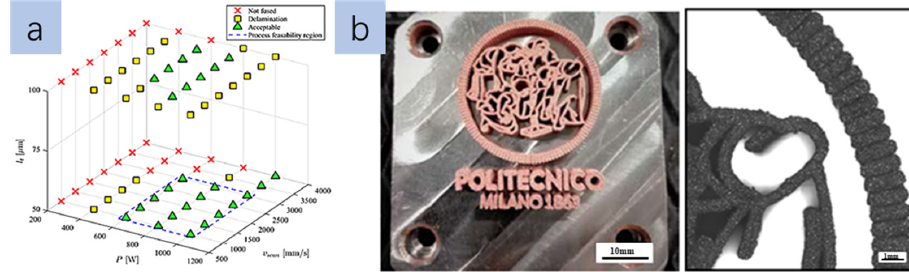
Figure 11. ( a ) Qualitative categorization of process outcome; ( b ) Final demonstrator produced by pure copper powder. Adapted from [42] Elsevier, 2018.